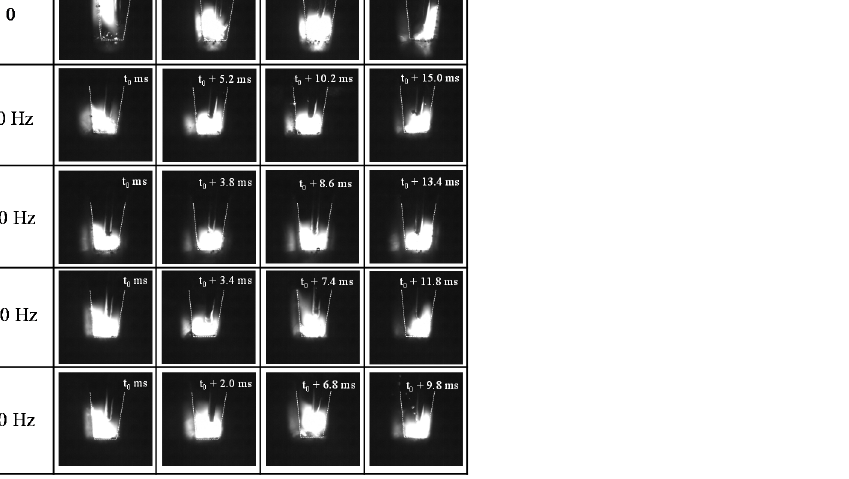
Figure 5. Arc shape under different magnetic frequency with a fixed intensity of 16 mT.